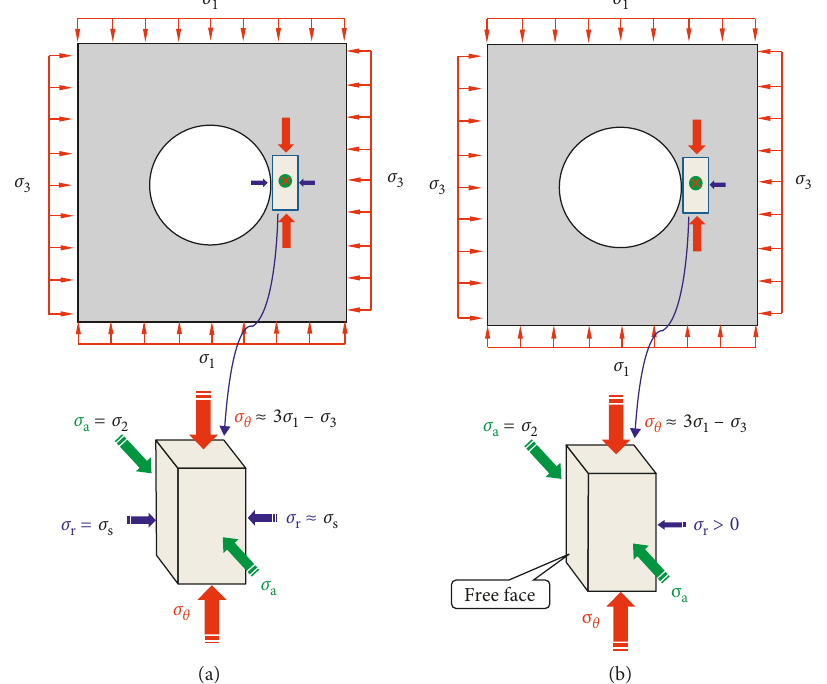
Figure 2: The stress state of the supported rock masses during rockburst: (a) before support failure and (b) after support failure. σ σ 3 are the major, intermediate, and minor initial stresses, respectively. σ θ , σ a , and σ r denote the tangential, axis, and radial stresses of rock masses near the excavated boundary. σ s is the stress provided by the